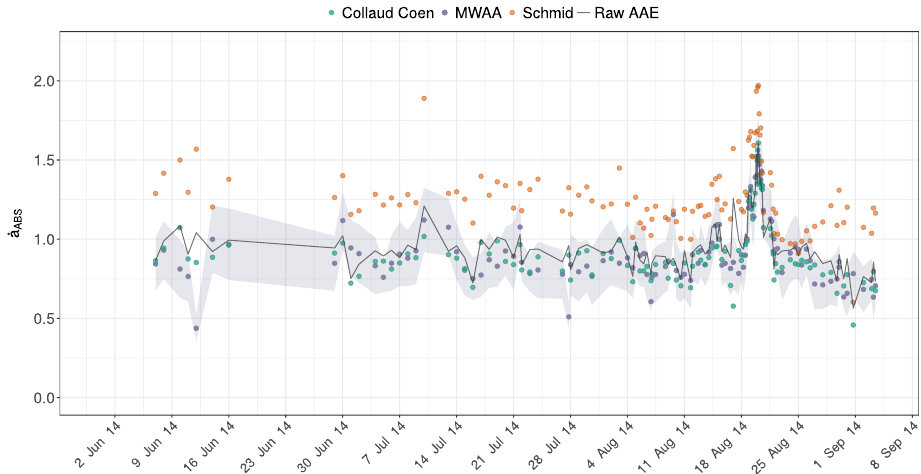
Figure 6. Wavelength dependence retrieved from MWAA absorption data and its standard error (purple points and shaded area), raw atten- uation data (gray line), and Schmid (orange points) and Collaud Coen (green points) corrected absorption data, all averaged over MWAA sample intervals. Error lines were removed to improve visualization.